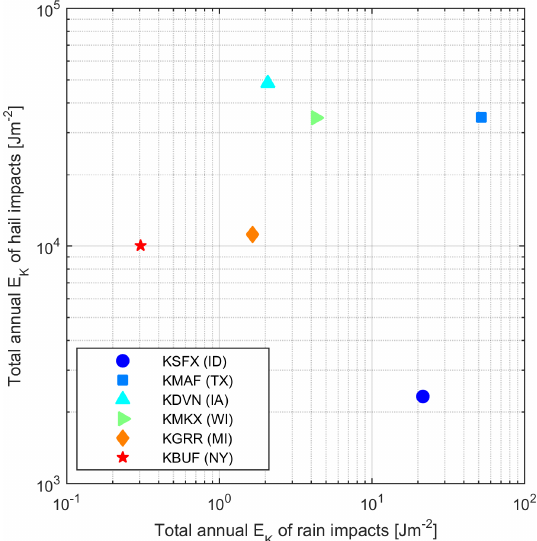
Figure 6. Total annual kinetic energy ( E K ) per square meter of blade leading edge from rain and hail impacts at each